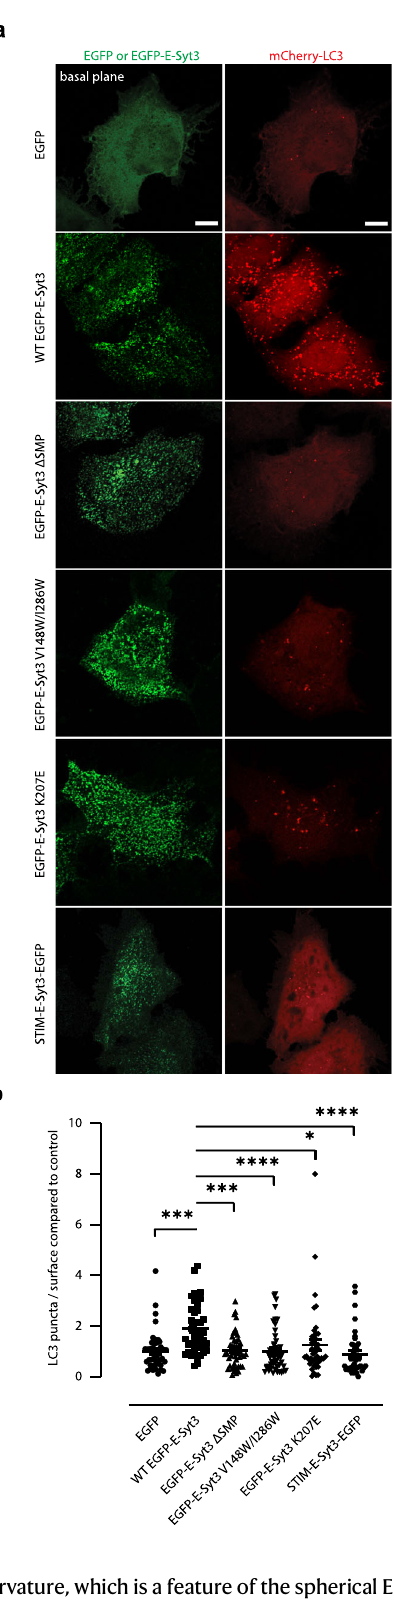
Fig. 6 | Lipid transfer by E-Syt3 contributes to autophagosome biogenesis. a Confocal images of HeLa cells co-expressing mCherry-LC3 and WT or mutated EGFP-E-Syt3.Scalebar,10 μ m. b Quanti fi cationofLC3punctaperareacomparedto control. Data are presented as mean±SEM ( n =42, 42, 47, 51, 45, and 42 cells from left to right). * P <0.05, *** P<0.001, **** P <0.0001 by one-way ANOVA with Bon- ferroni ’ s multiple comparisons test. P values: 2.4×10 − 4 [(EGFP) vs (WT EGFP-E- Syt3)], 3 4 × 10 − 4 [(WT EGFP-E-Syt3)vs(EGFP-E-Syt3 Δ SMP)],8.9×10 − 5 [(WT EGFP-E- Syt3) vs (EGFP-E-Syt3 V148W/I286W)], 0.020 [(WT EGFP-E-Syt3) vs (EGFP-E-Syt3 K207E)], 1.9×10 − 5 [(WT EGFP-E-Syt3) vs (STIM-E-Syt3-EGFP)]. Source data are pro- vided as a Source Data fi